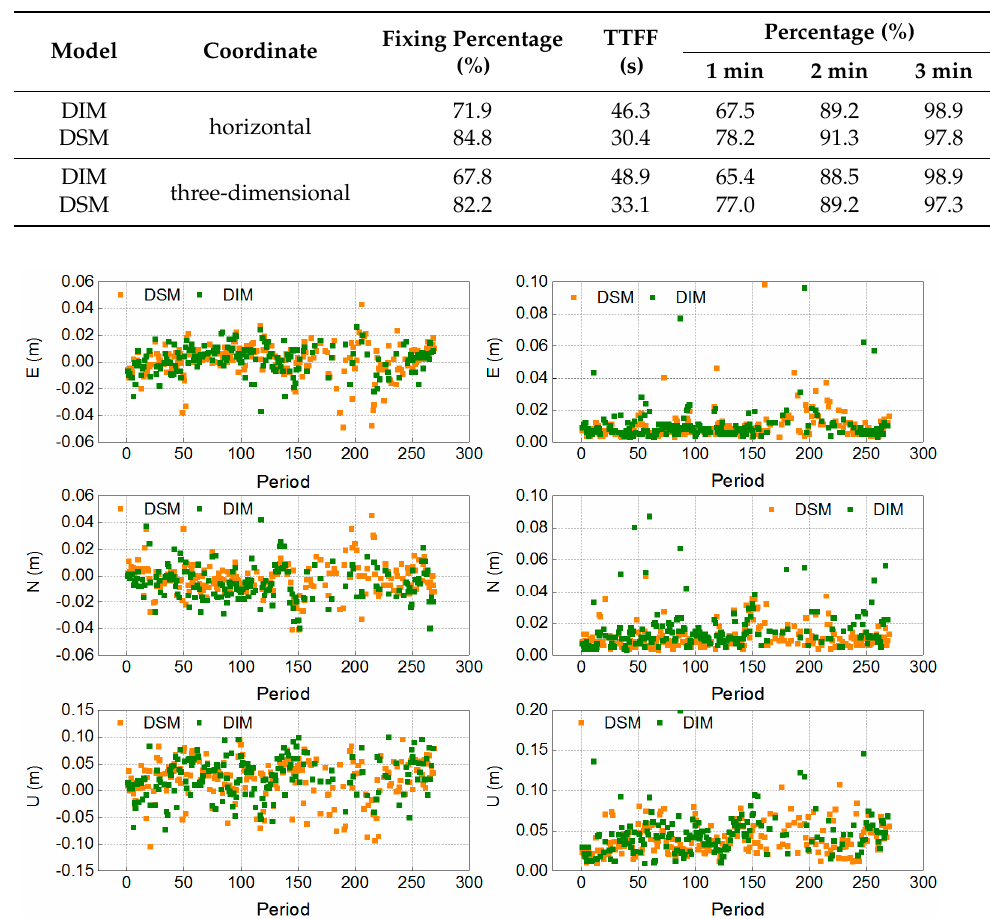
Figure 9. Positioning bias at TTFF ( left ) and RMS values after convergence ( right ) for large- scale